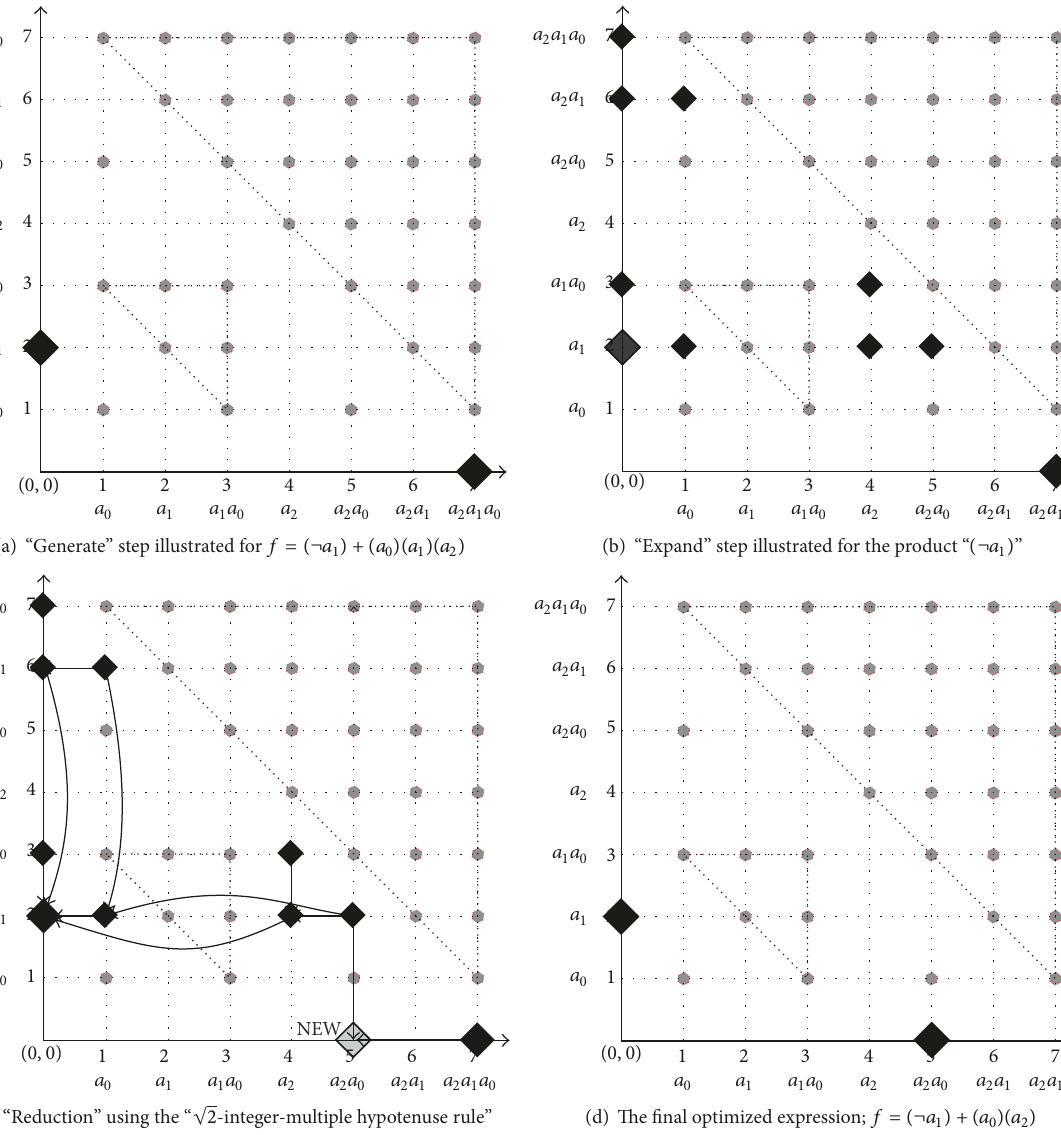
Figure 6: Process of optimization; the steps in order are